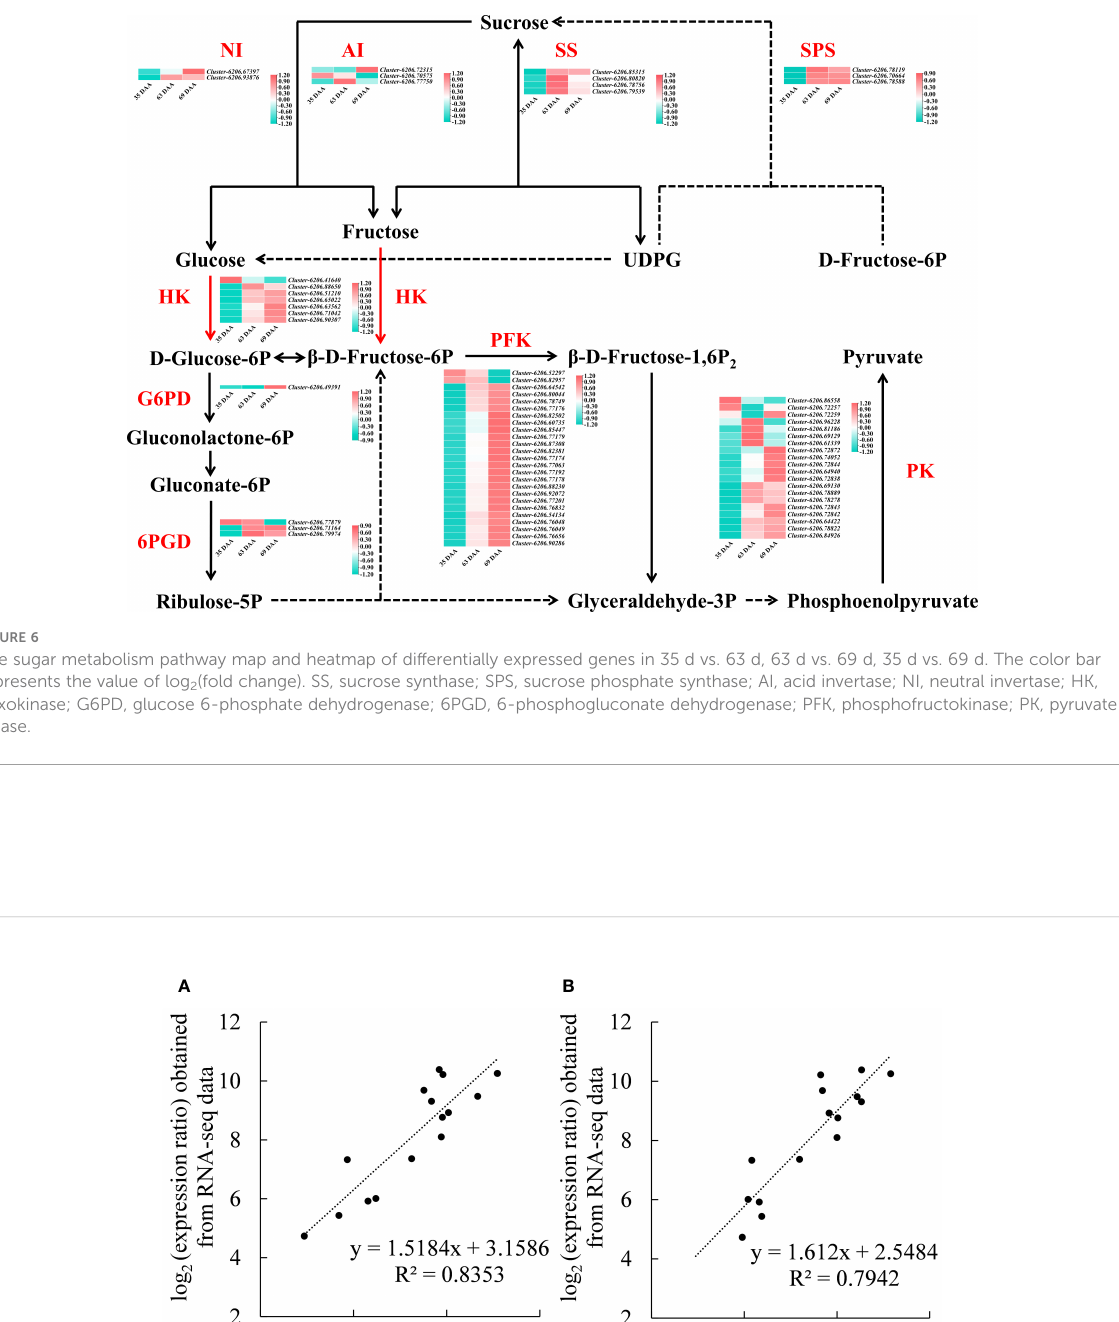
FIGURE 7 Coef fi cient analyses of gene expression levels obtained from the transcriptome sequencing (RNA-Seq) and real-time PCR data. Scatterplots were generated by the log 2 (expression ratios) from real-time PCR (x-axis) and RNA-seq (y-axis) in (A) 2020 and (B) 2021.